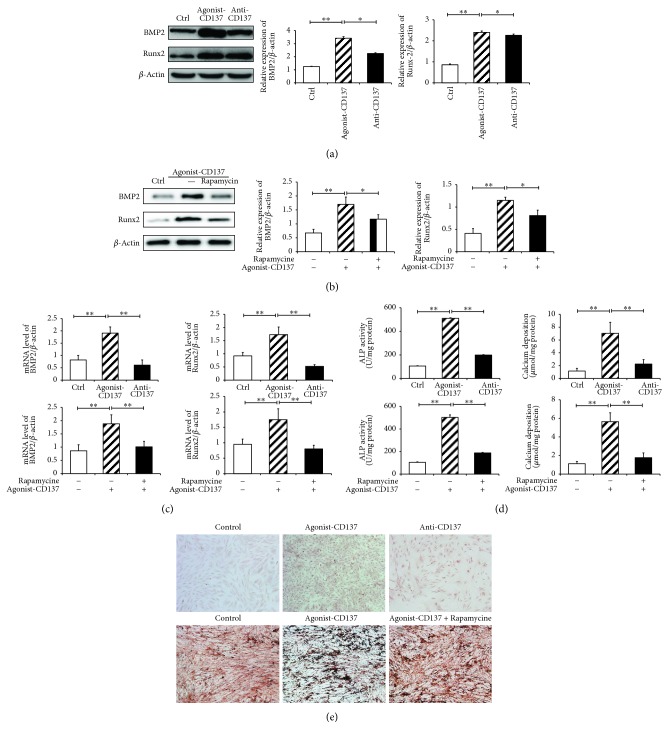
Preincubation with autophagy stimulator rapamycin attenuated CD137 signaling induced VSMCs calcification. (a–c) The protein and mRNA levels of BMP2 and Runx2 were analyzed by Western blot and RT-PCR, respectively. (d) Image showing extracellular ALP activity and calcium deposition in each group. (e) Von Kossa staining was applied to detect the calcification in VSMCs of each group. Data are expressed as the mean ± SEM of at least three independent experiments.∗ refers to P < 0.05; ∗∗ refers to P < 0.01.